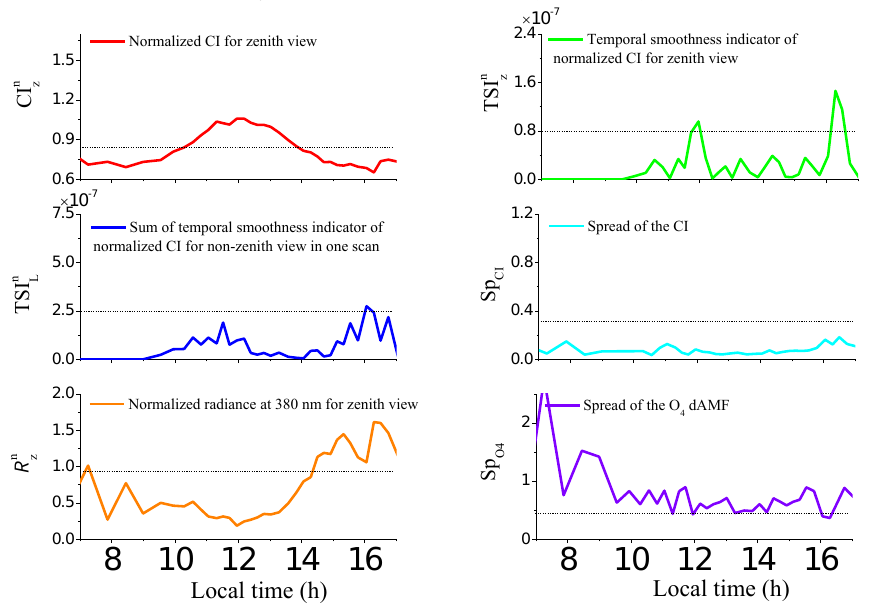
Figure 7. Time series of the quantities (same as in Table 1) derived from MAX-DOAS for 8 July 2012, categorized as “continuous clouds (small SZA)”. The dashed line presents the thresholds of each quantity. The normalized CI (top left) is the same as in Fig.